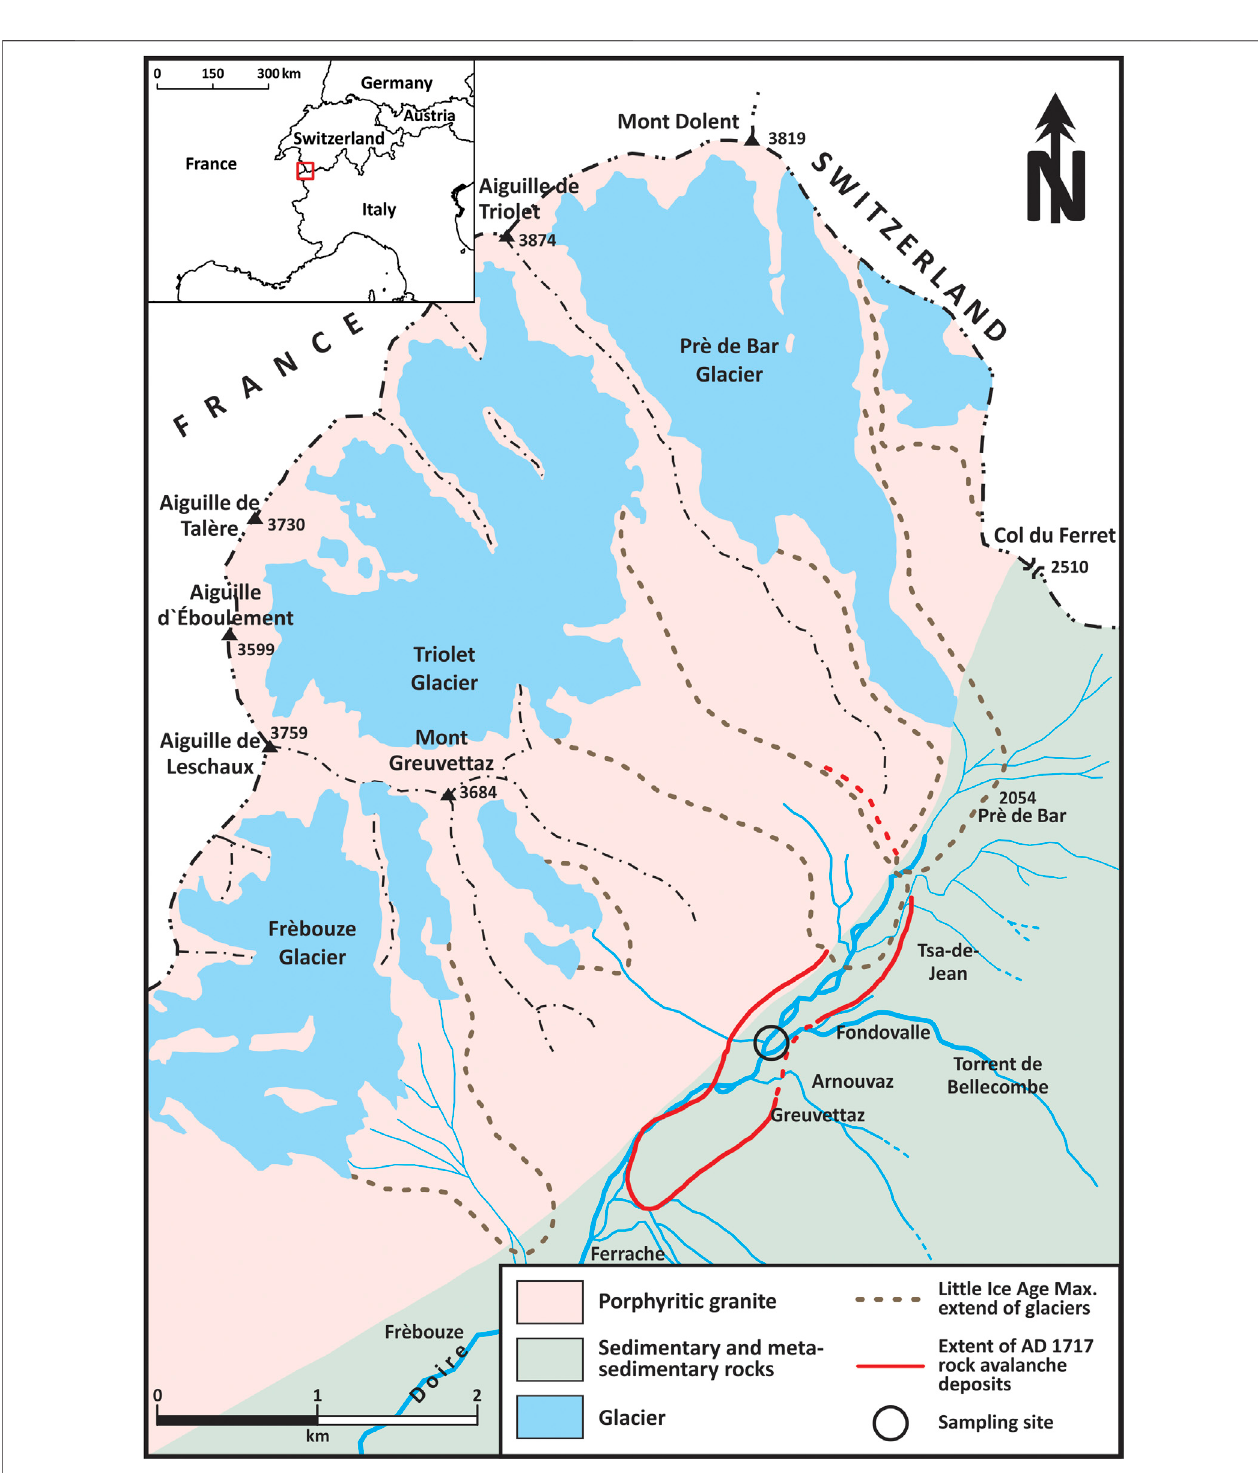
FIGURE 1 | Location of the study site, Arp Nova plain in the Ferret Valley, Italy (45.871341157559634, 7.05089817967189). Figure modi fi ed after Akçar et al. (2012).